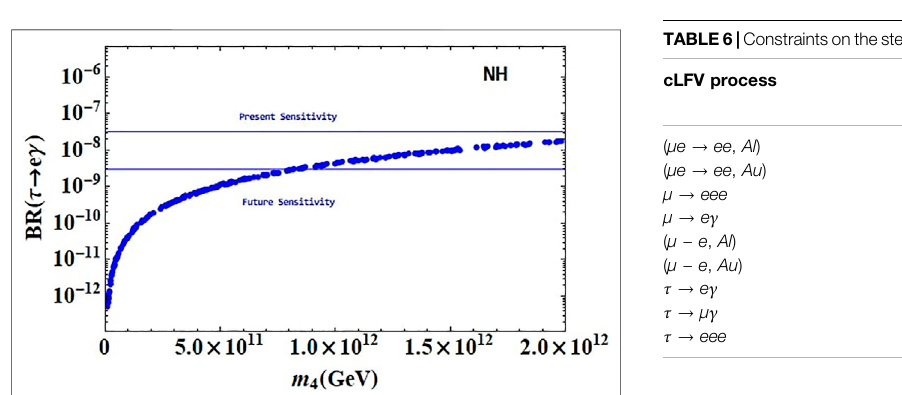
FIGURE 9 | BR ( τ − e c ) as a function of the sterile neutrino mass. The blue horizontal line represents the experimental bounds on this process.